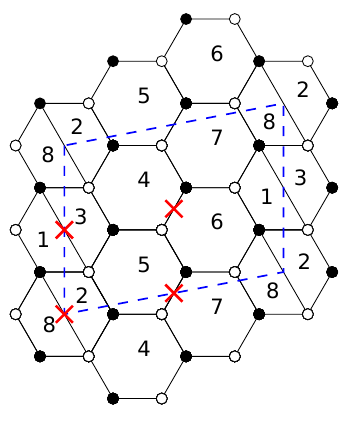
Figure 11 . PdP 5 b dimer with orientifold